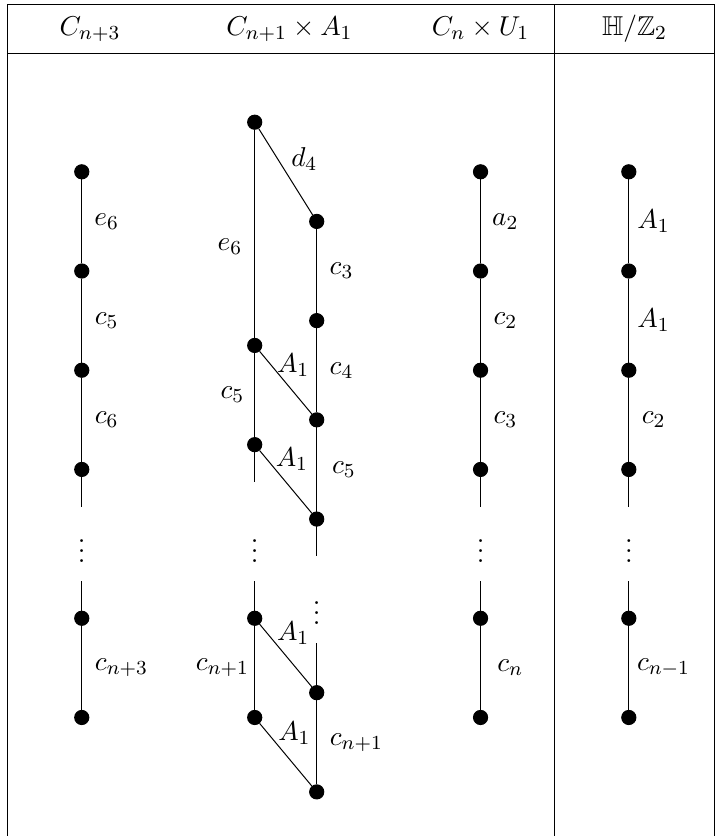
Table 13 . The n = 1 case of these families correspond to the magnetic quivers of 4 d 1 theories whose Higgs branch are H = Z k orbifolds for k = 2 ; 3 ; 4 ; 6.